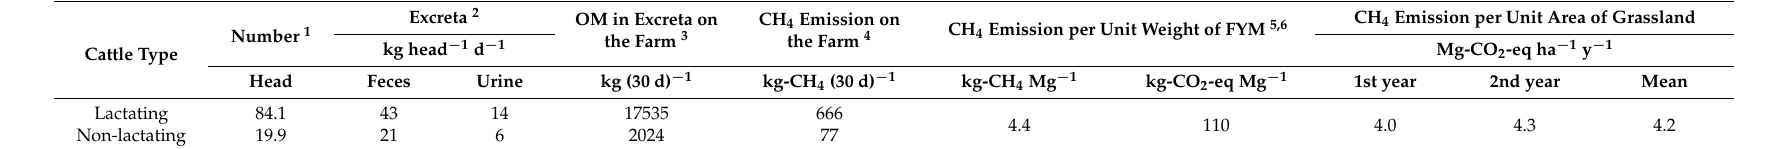
Table 2. Emission of CH 4 related to composting.